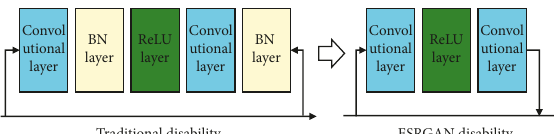
Figure 3: Comparison of traditional residual block and ESRGAN residual